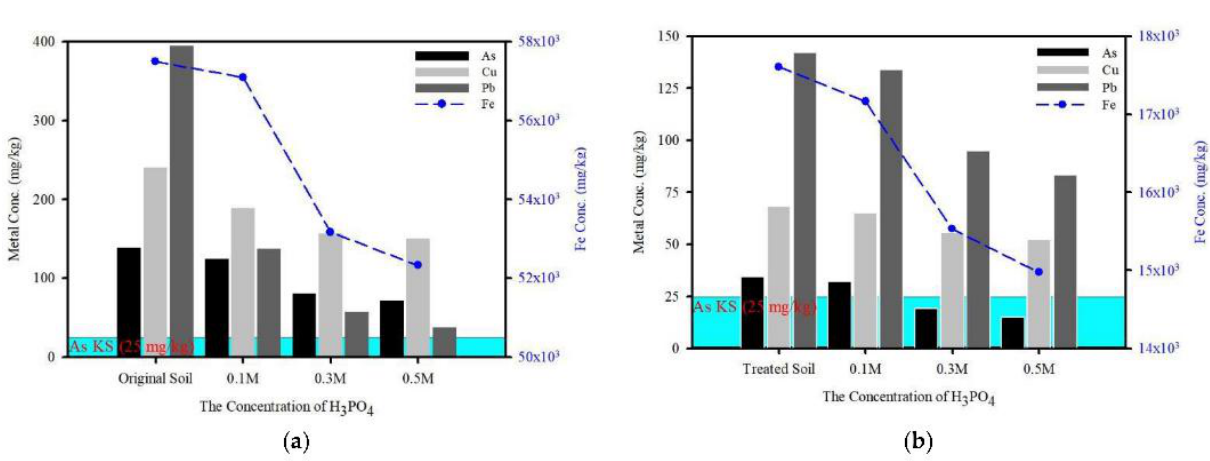
Figure 11. Effect of phosphoric acid concentrations on enhanced toxic heavy metals extractions from the original soil ( a ) and treated soil ( b